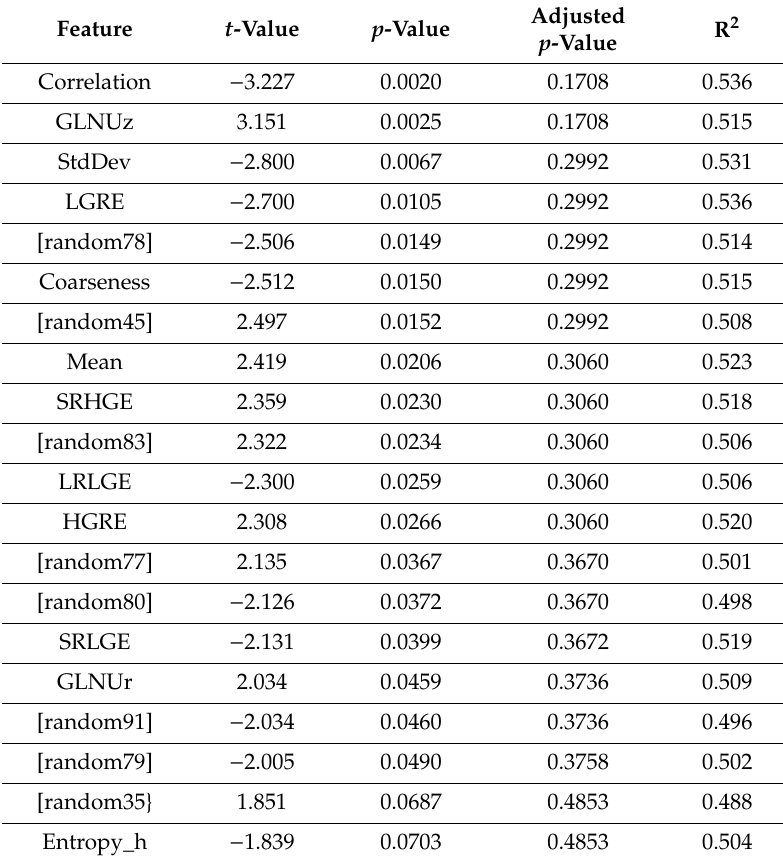
Table 3. Predictors (top 20) of ctDNA maf calculated from feature-by-feature linear mixed models with lesion volume included as a fixed e ff